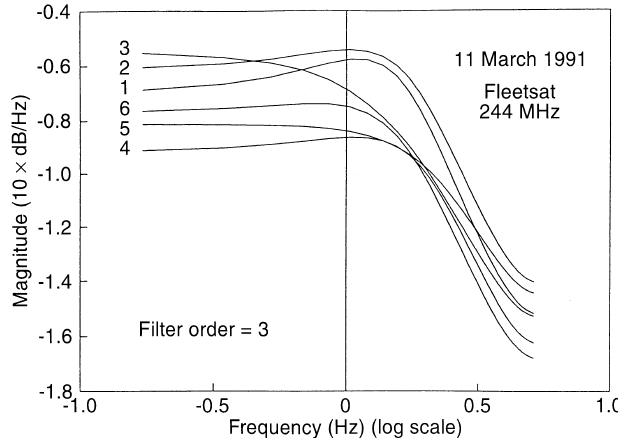
Fig. 7. Typical power law spectra represented by a flat power spectral density up to » 3.3 Hz and the higher frequency roll-off giving a single component spectral slope. The spectra are numbered 1–6 representing the time sequence of their